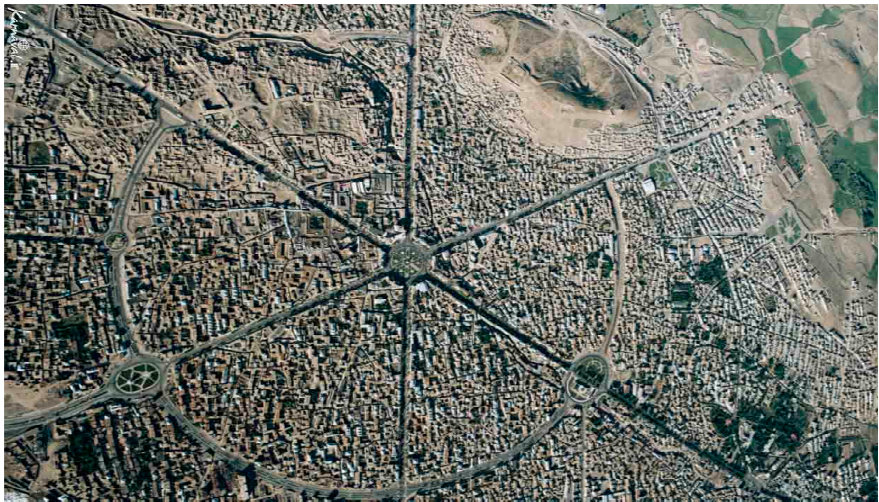
Figure 2. Radial form of the structure of Hamadan. Reference: Google Earth. 4 July, 2019.